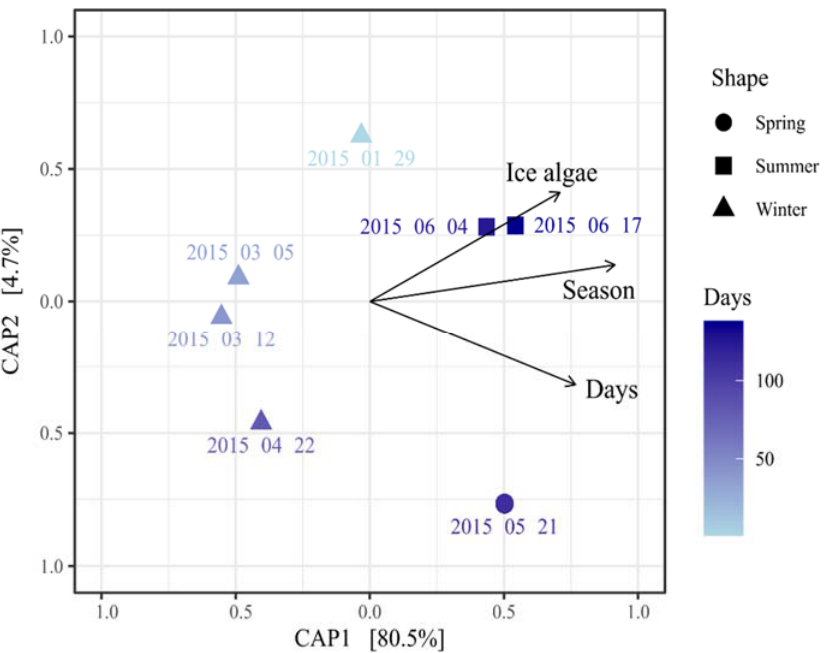
Figure 5. Constrained analysis of principal coordinates analyses including season, ice algae, and days as main factors determining the bacterial and archaeal community.